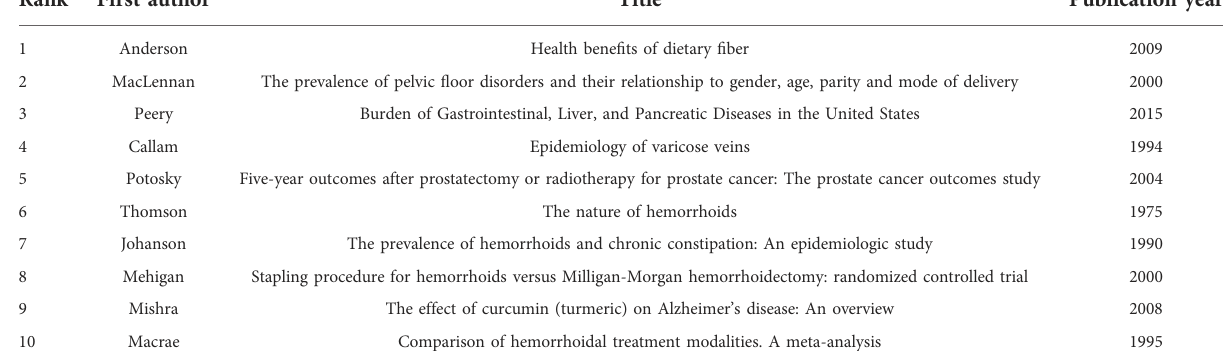
TABLE 1 Top 10 most-cited